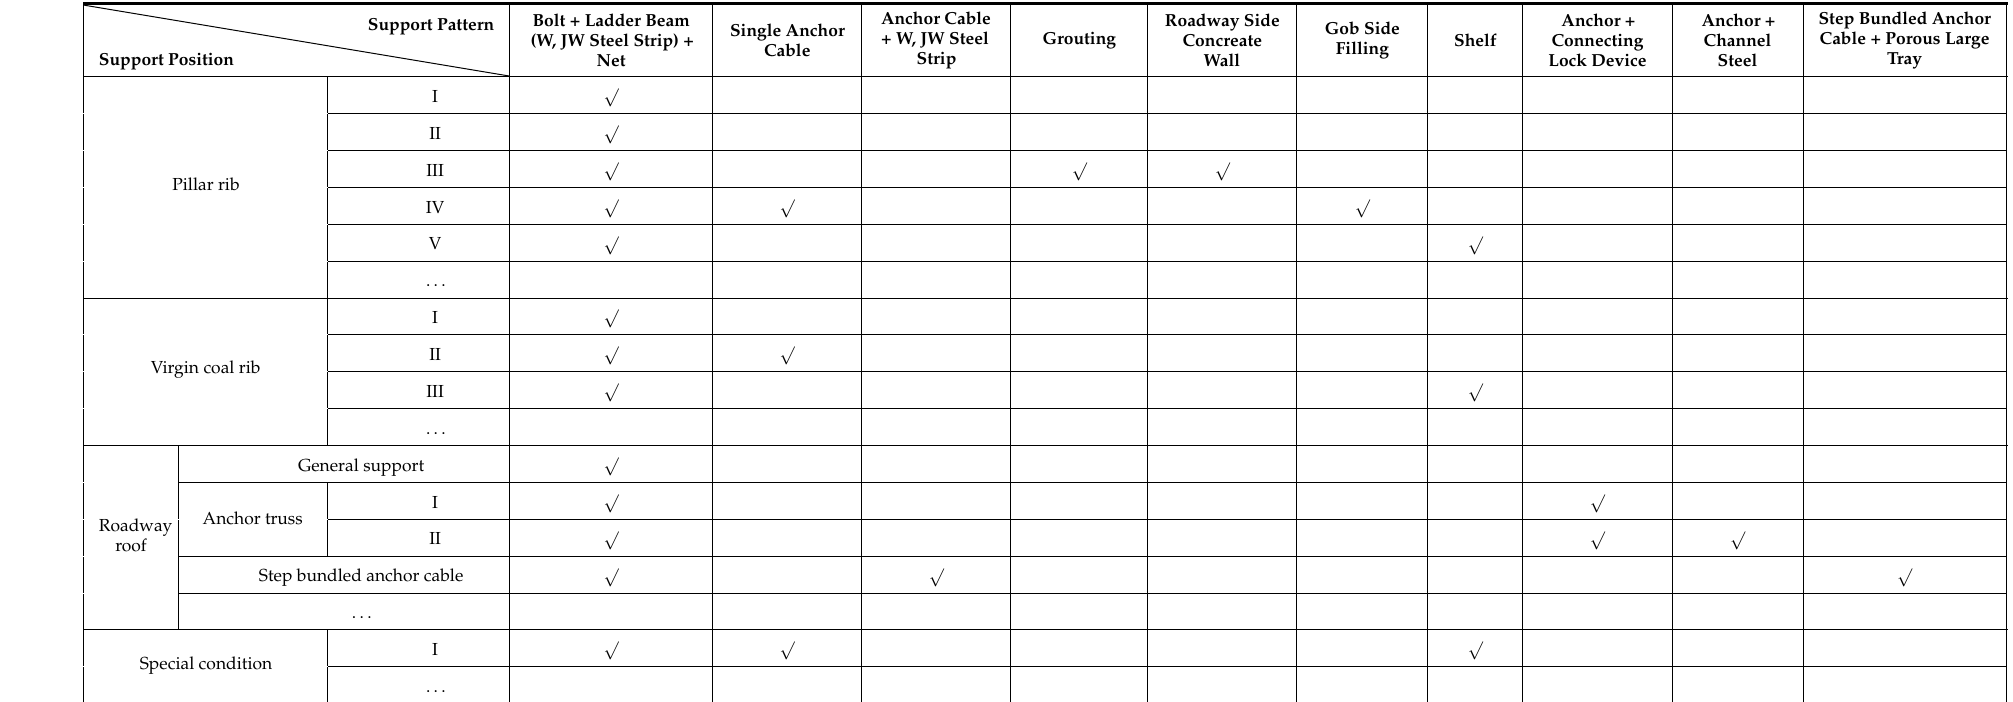
Table 1. Roof combined support table of gob-side entry driving in fully mechanized